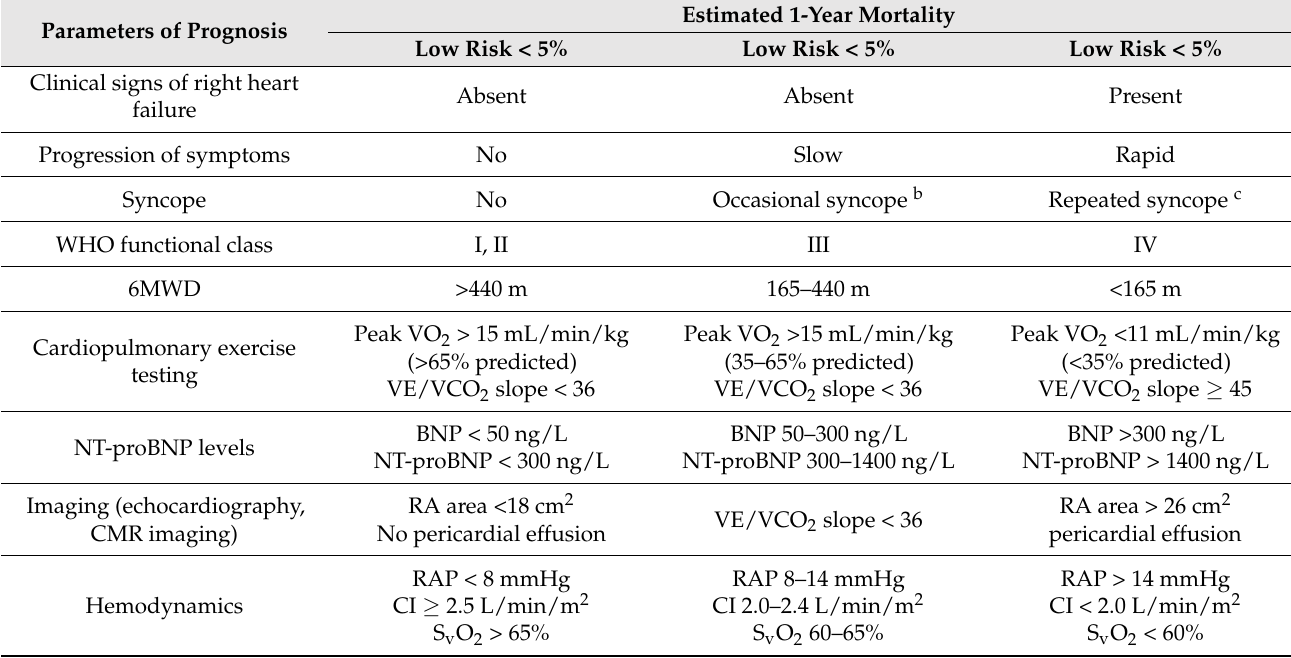
Table 4. 2015 European Society of Cardiology (ESC)/European Respiratory Society (ERS) guidelines for the risk assessment of patients with PAH a . Estimated 1-Year Mortality Parameters of Prognosis